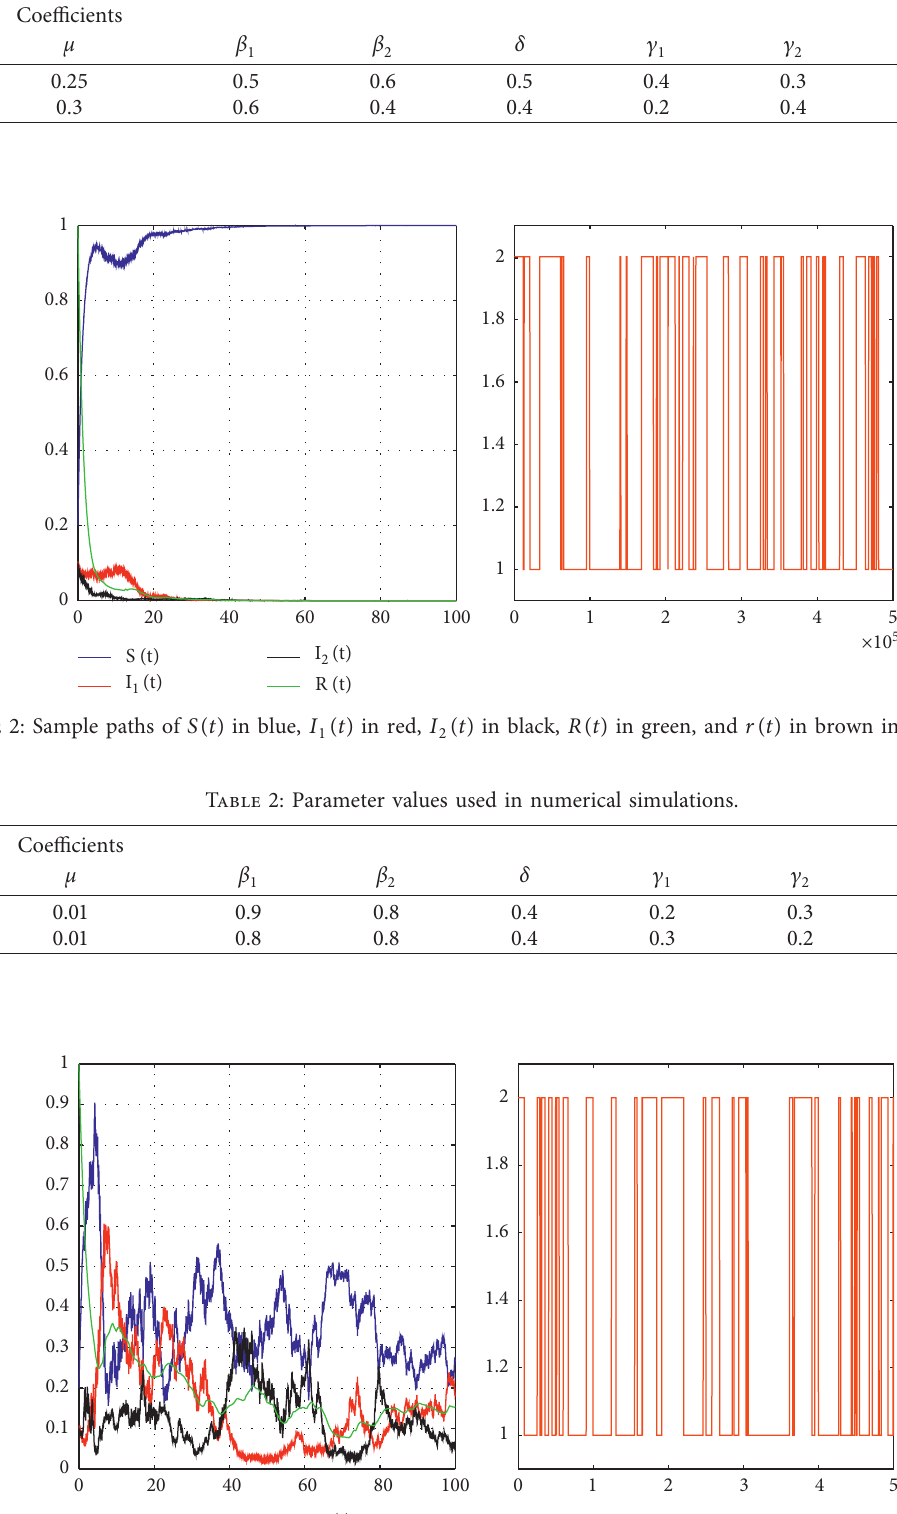
( t ) in red, I ( t ) in black, R ( t ) in green, and r ( t ) in brown in Example 1 2